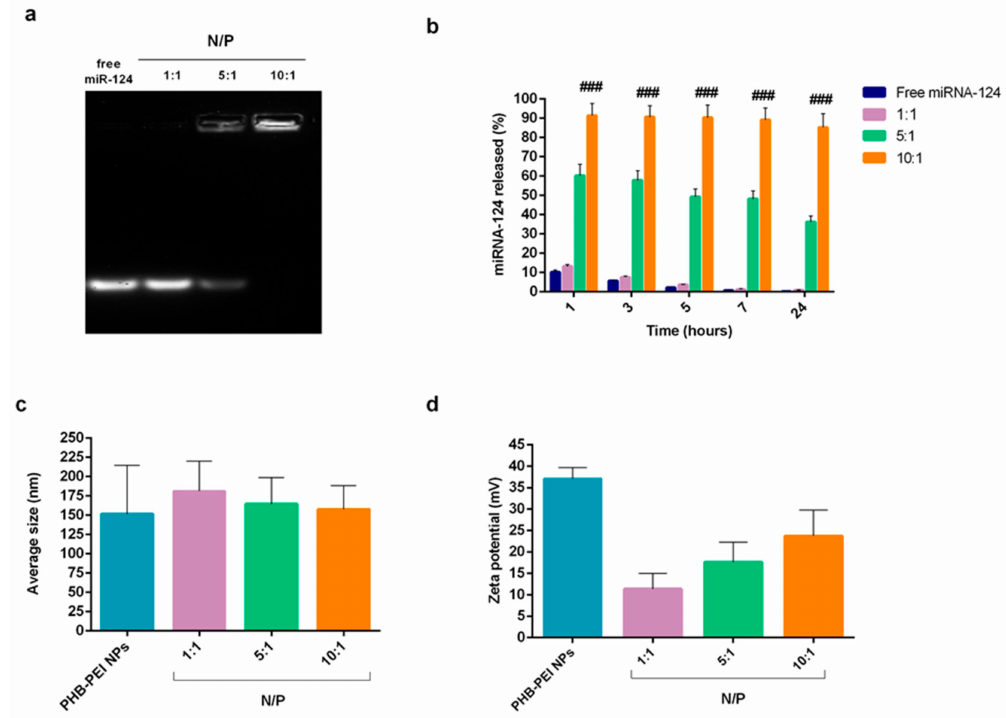
Figure 2. Characterization of PHB-PEI NPs / miR-124 complexes. ( a ) Electrophoretic mobility of miR-124 NPs at di ff erent N / P ratios. ( b ) miRNA-124 release profile evaluated by qRT-PCR analysis for 24 h in growth medium. Free miR-124 was used as control. ( c ) Average hydrodynamic diameter and ( d ) zeta potential of miR-124 NPs at di ff erent N / P ratios (mean ± SD, n = 6). Statistically significant variations: ### p < 0.001 N / P 10:1 versus N / P 5:1, N / P 1:1, and free